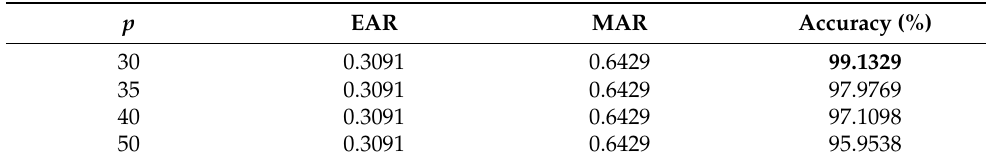
Table 6. Comparison with different combination thresholds on the HNUFDD dataset for fatigue driving behavior recognition.